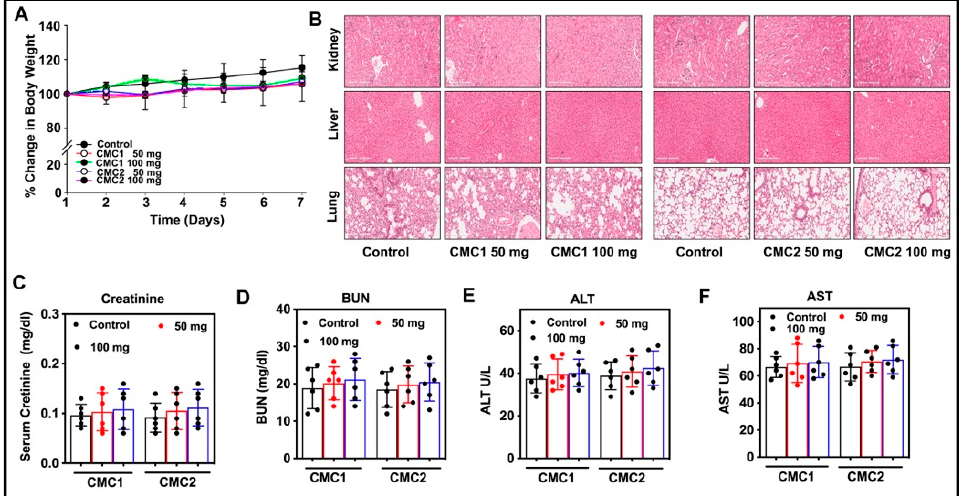
Figure 6. CMC conjugates are safer and do not show any contraindication. Normal C57BL/6 mice ( n = 6) were treated with CMC1 and CMC2 at two different concentrations (50 and 100 mg/kg body) by oral gavage for 7 days. Bodyweight, ( A ) movement, hair loss, food, and water intake were monitored. At the end of the experimental period (7 days after the treatment), mice were euthanized, tissues (kidney, liver, and lung) were collected to monitor morphological changes by H&E staining. Representative images are shown at 20x magnification ( B ). Blood samples were collected to measure Creatinine ( C ), BUN ( D ), ALT ( E ), and AST ( F ) levels. Values are shown as the mean ± SD of 6 animals in each group.